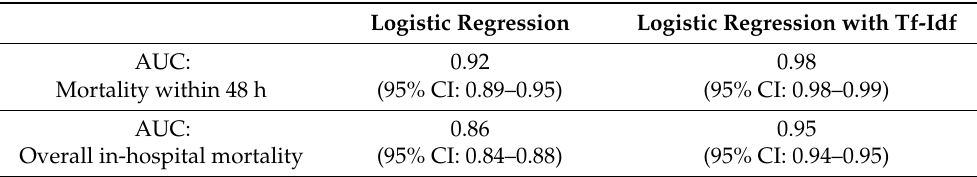
PPV 0.11. Figure 8a,b present word clouds of terms importance.